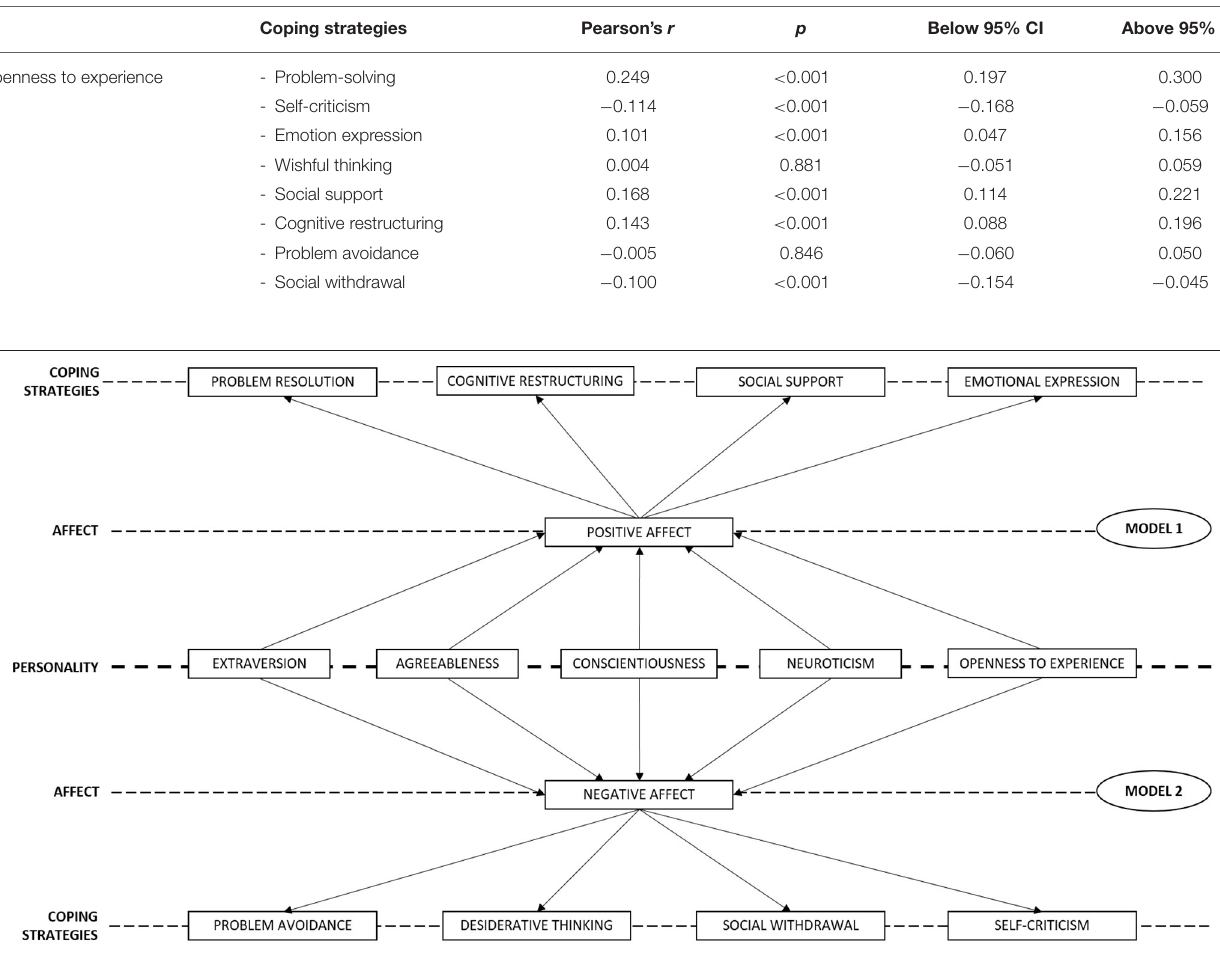
FIGURE 1 | Hypothetical mediation